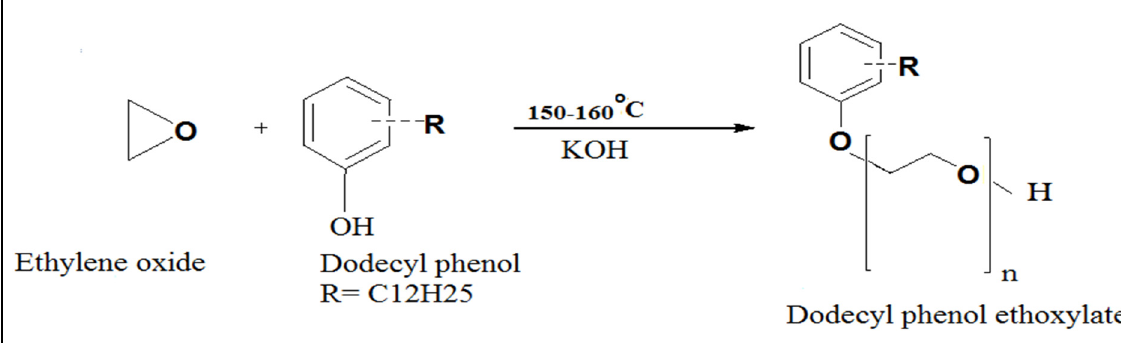
Figure 3. Synthesis route of oleic acid ethoxylate.